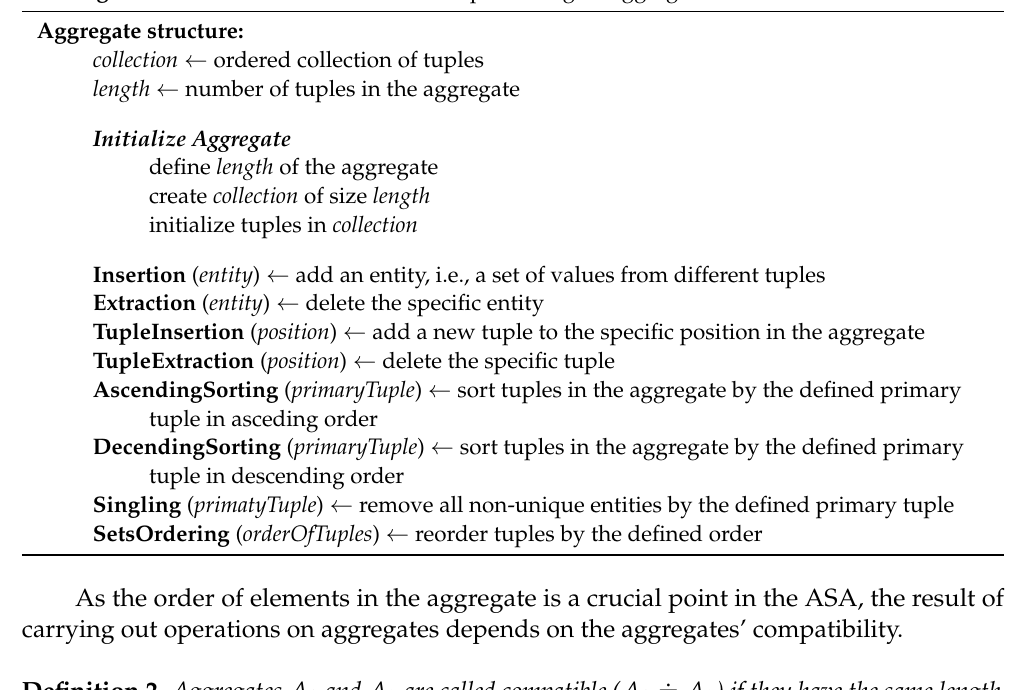
Figure 4. An example of two hiddenly compatible aggregates. Figure 1. An example of two compatible aggregates. Definition 3. Aggregates 𝐴 (cid:2869) and 𝐴 (cid:2870) are called quasi-compatible ( 𝐴 (cid:2869) ≐ 𝐴 (cid:2870) ) if the type and se- quence order of the sets in them partially coincide, while there is no requirement for the equality of the lengths of these aggregates, i.e., the conditions are fulfilled: (cid:3420) (cid:4668)𝐴 (cid:2869) (cid:4669) ≢ (cid:4668)𝐴 (cid:2870) (cid:4669) (cid:4668)𝐴 (cid:2869) (cid:4669) ∩ (cid:4668)𝐴 (cid:2870) (cid:4669) (cid:3405) ∅.